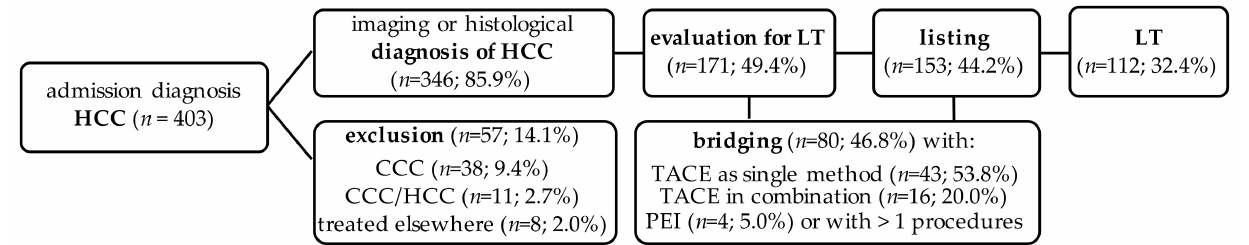
Figure 1. Flowchart of the LT cohort. Bridging with >1 procedures included: PEI, radiofrequency ablation, TACE and/or resection. Abbr.: CCC: cholangiocellular carcinoma; HCC: hepatocellular carcinoma; LT: liver transplantation; PEI: percutaneous ethanol injection; TACE: transarterial